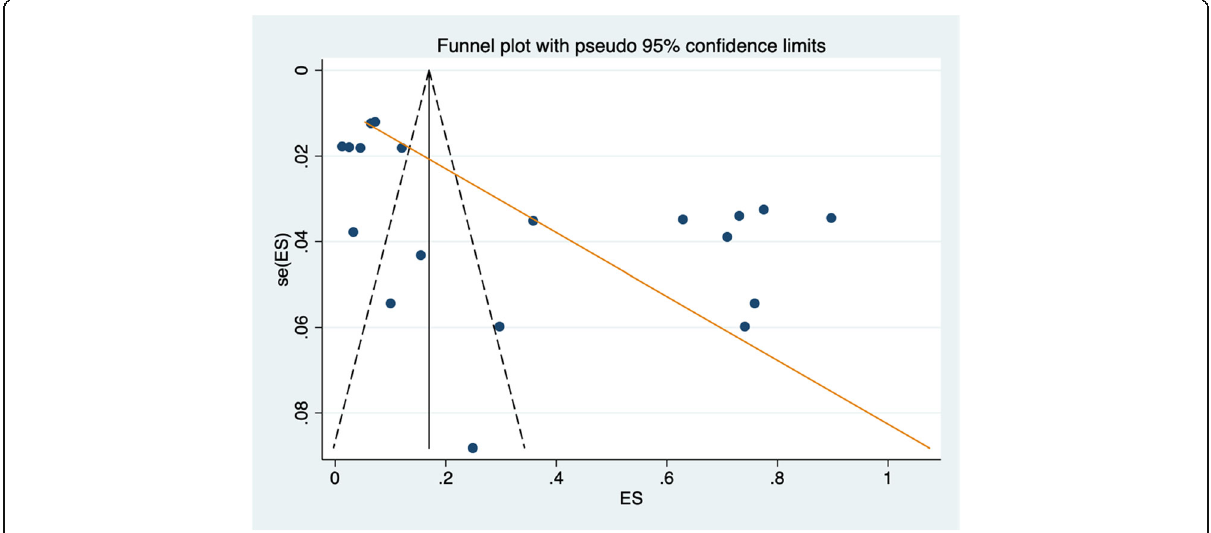
Fig. 5 Funnel plot for assessing the presence of publication bias